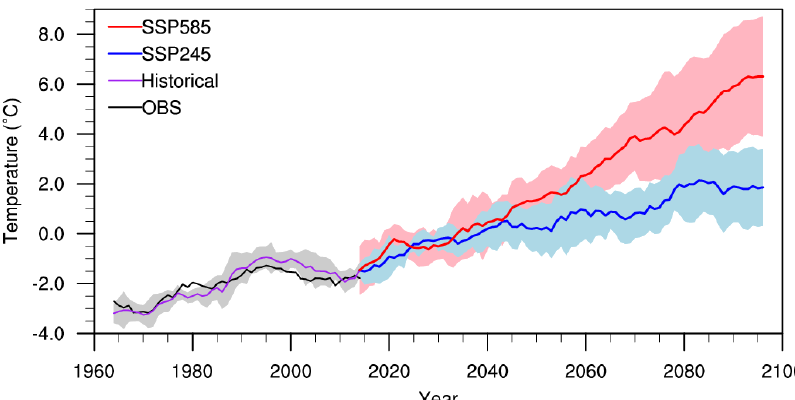
Figure 4. Multi-model ensemble means of the 9 year smoothed winter mean temperature (unit: °C) for the historical simulations (purple line) during 1960–2014, as well as the simulations under the SSP245 (blue line) and SSP585 (red line) scenarios during 2015–2100 in Beijing. The black line denotes the observation, and shadings indicate the model spread. Table 2. Percentage changes in the natural gas consumption (unit: %) with respect to temperature changes (unit: °C) during heating season under the SSP245 and SSP585 scenarios relative to 1995– 2014 in Beijing. Values in the bracket denote the model spread.